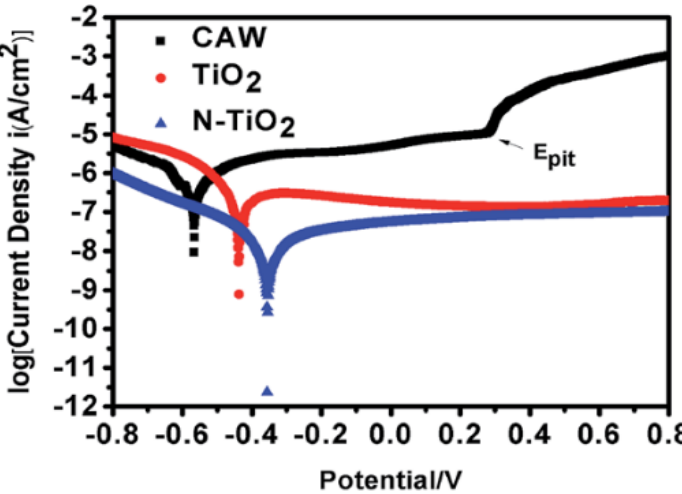
Figure 9. Potentiodynamic polarization curves of CAW, TiO 2 coat-CAW and N-TiO 2 coated CAW [15].